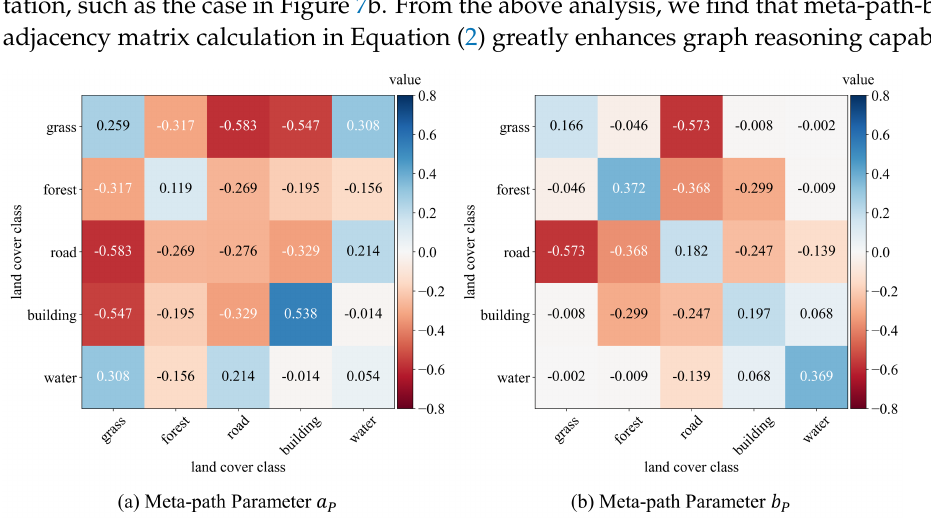
Figure 8. Symmetric meta–path parameters a P , b P in edge calculation. The values are rendered with the color bar on the right, with positive values appearing in blue and negative values in red.